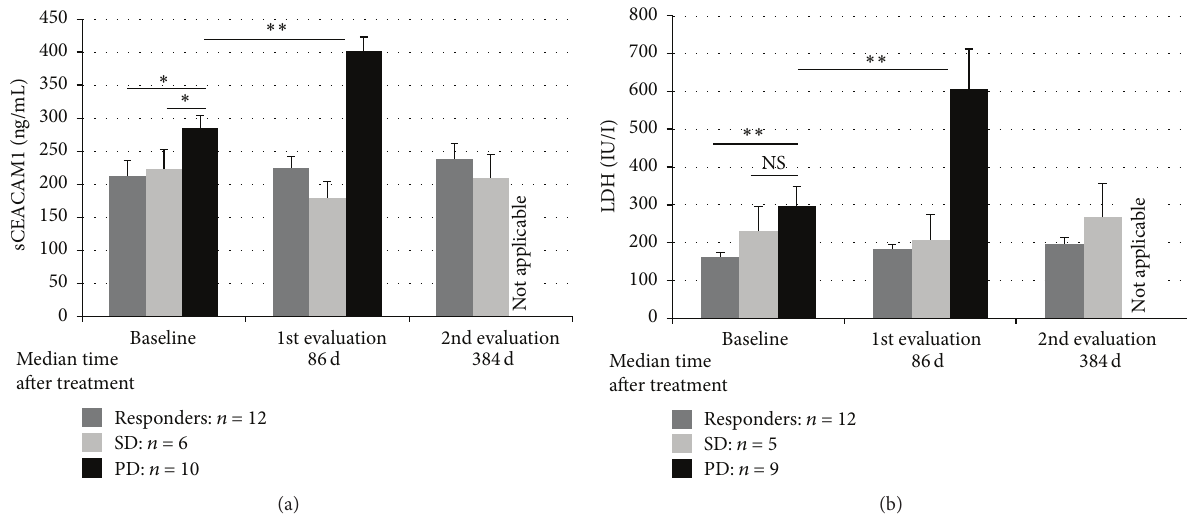
Figure 4: sCEACAM1 and LDH are elevated in melanoma patients who fail to respond to immunotherapy. sCEACAM1 (a) and LDH (b) levels were measured in clinically derived serum samples of AJCC stage IV metastatic melanoma patients that underwent immunotherapy with tumor infiltrating lymphocytes before as well as at 2 points after treatment (except for PD patients who passed away before the later time point). Statistics were assayed by regular Student’s 𝑡 -test.